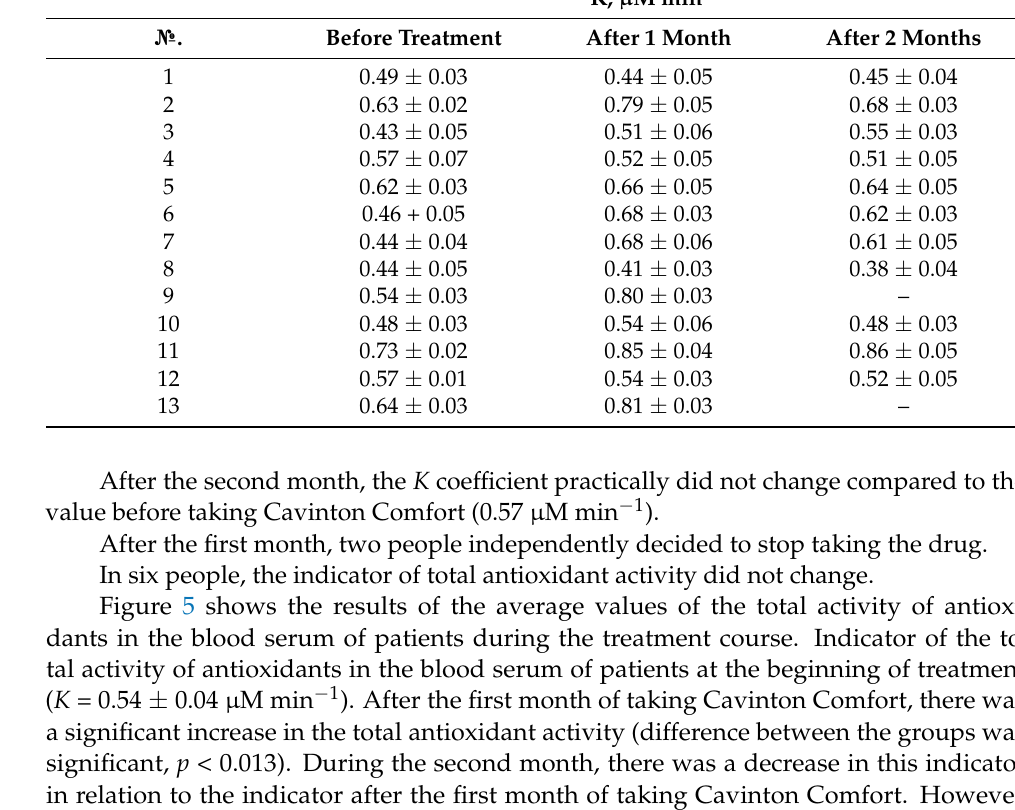
Table 1. The value of the total activity of antioxidants in the blood serum of patients with chronic cerebral ischemia of the first degree ( p = 0.95, n = 3) when taking the pharmacological drug Cavin- ton Comfort. №.